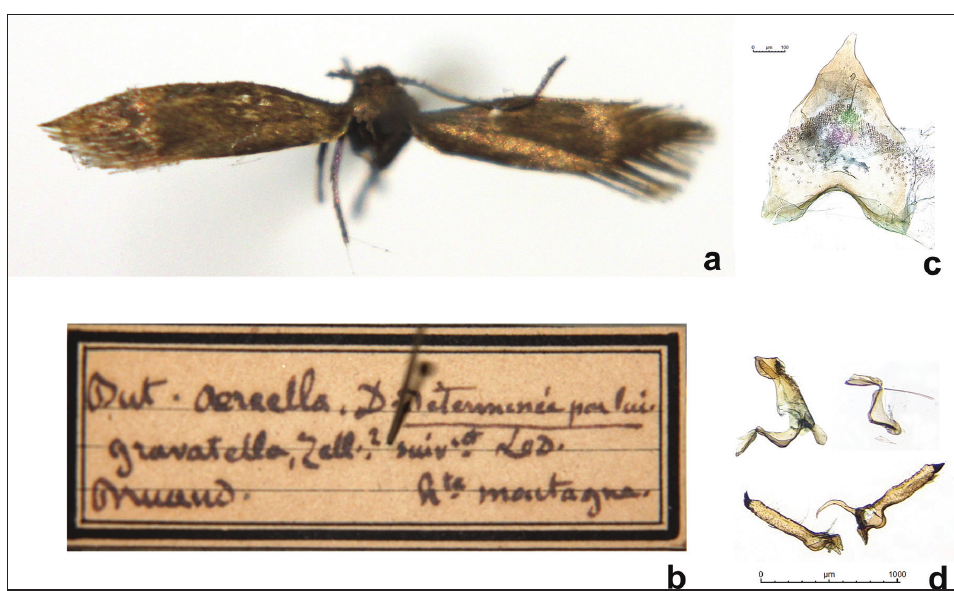
Figure 4. Scythris laminella (D. & S., 1775) (identified by Bruand as Butalis ( Lita ) aereella